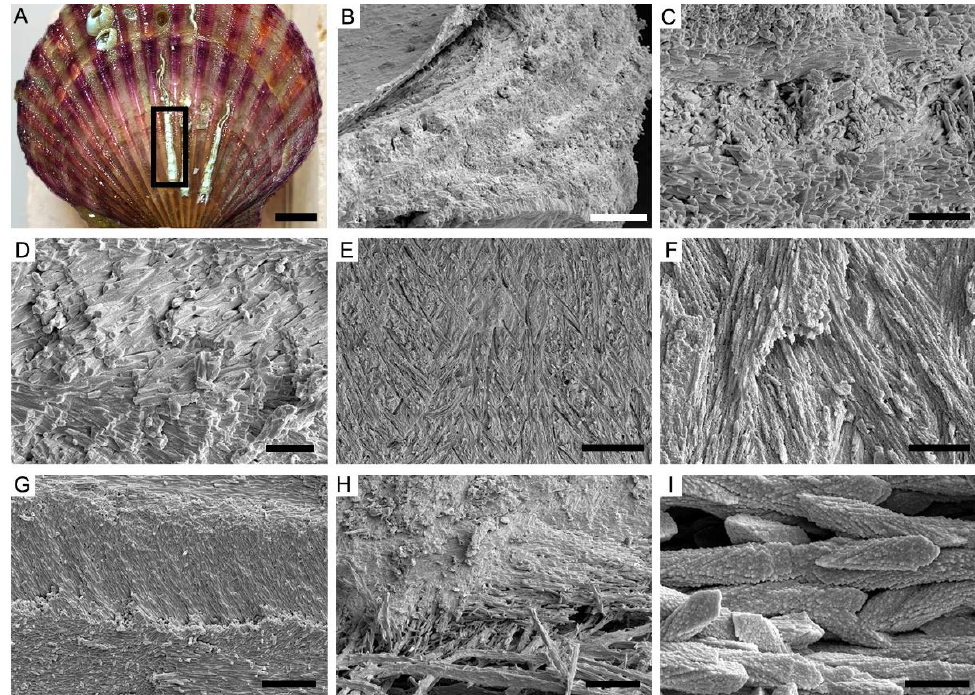
Figure 4. The ordered-chevron microstructure of serpulid tubes Hydroides elegans . ( A ) Specimen OUCCMG An00002, serpulid tubes encrusted on surface of bivalve Azumapecten farreri shells. ( B – D ) Specimen OUCCMG An00003, fractural surface of tube showing distinct growth increments of the ordered-chevron form. ( E – G ) Specimen OUCCMG An00004, fibrous and crisscrossed organiza- tion of crystals on internal surface of the tube; different orientations of crystals are marked by yellow and red lines, respectively. ( H ) Specimen OUCCMG An00005, close-up image showing differently oriented prismatic crystals in adjacent lamellae (marked by different color lines) and organic matrix sheath. ( I ) Individual prisms have a rhombohedral morphology. Scale bars: 1 cm ( A ), 50 µ m ( E ), 20 µ m ( B , H ), 10 µ m ( G ), 5 µ m ( C , D , F ), and 2 µ m ( I